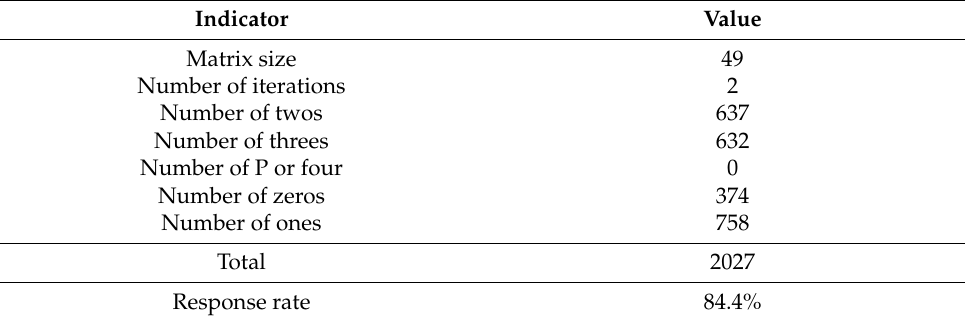
Table 2. Details on the dimensions of the structural analysis